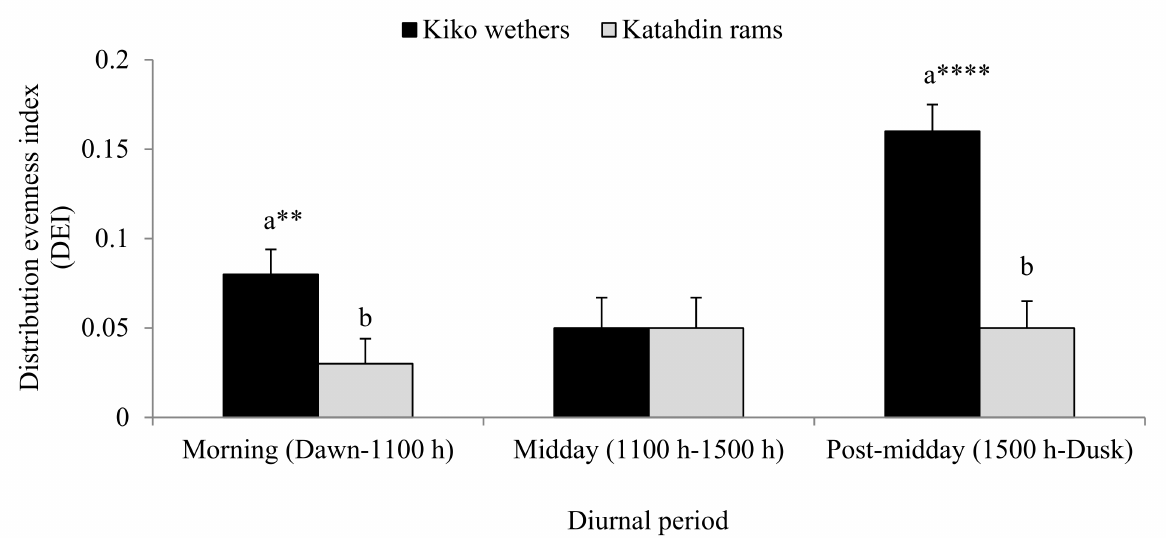
Figure 7. Distribution evenness index (DEI) (LS means ± SE) of Kiko wethers and Katahdin rams in woodlands, June– August 2018 ( a,b LS means with different letters within each diurnal period differ; ** p < 0.01, **** p <